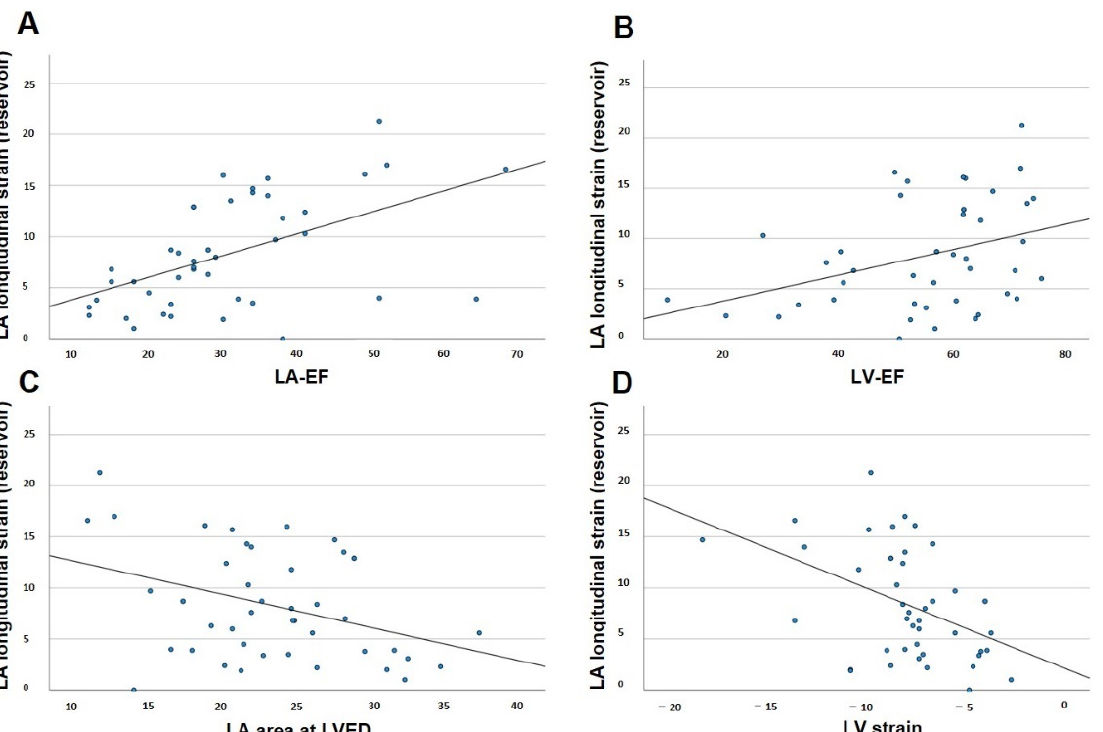
Figure 4. Pearson’s correlation for left atrial reservoir strain and disease-relevant factors in cardiac amyloidosis. ( A ) Correlation of left atrial reservoir strain and left atrial ejection fraction. ( B ) Correlation of left atrial reservoir strain and left ventricular ejection fraction. ( C ) Correlation of left atrial reservoir strain and end-diastolic left atrial area. ( D ) Correlation of left atrial reservoir strain and left ventricular strain. LA-EF: left atrial ejection fraction; LV-EF: left ventricular ejection fraction; LA: left atrial; LV strain: left ventricular global longitudinal strain; LVED: left ventricular end diastole.